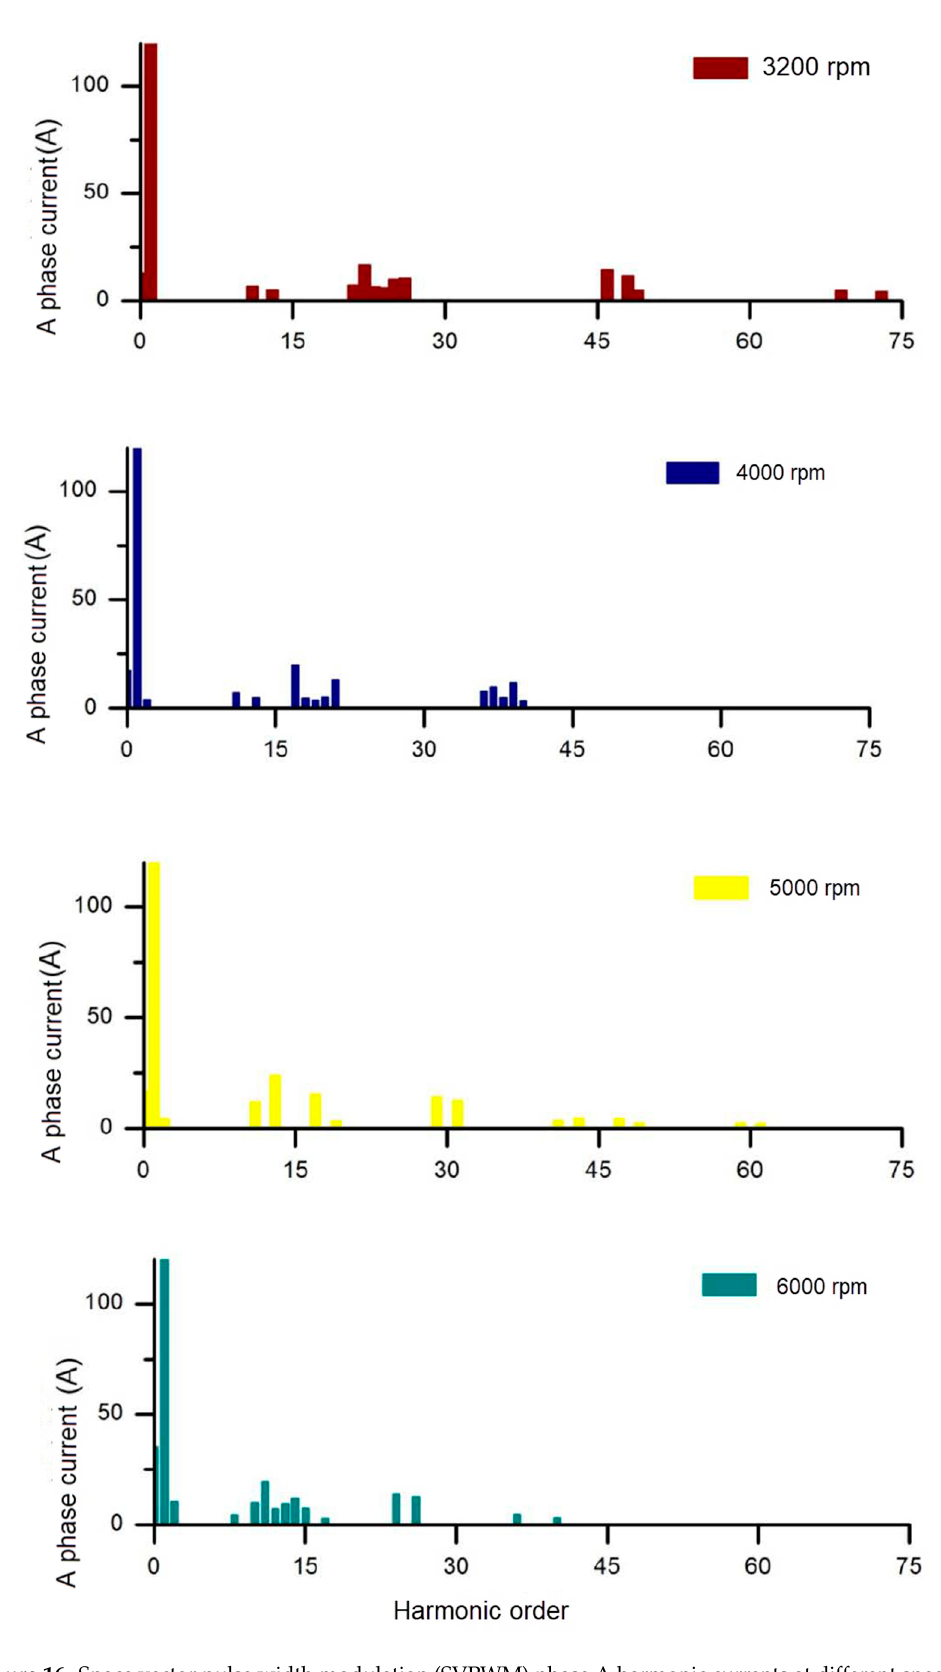
Figure 16. Space vector pulse width modulation (SVPWM) phase A harmonic currents at different speeds.